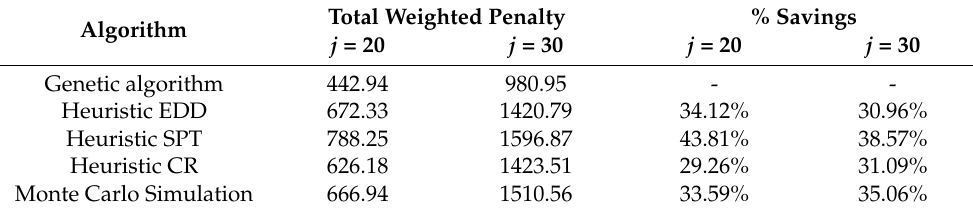
Table 2. Results for the GA compared to the